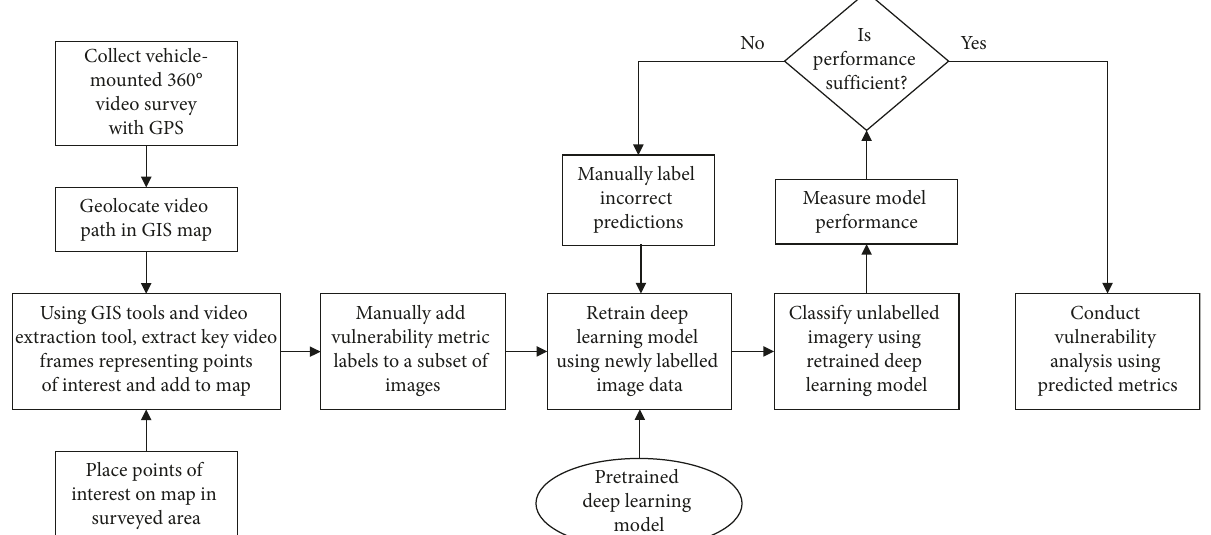
Figure 1: Workflow for vulnerability analysis using presented